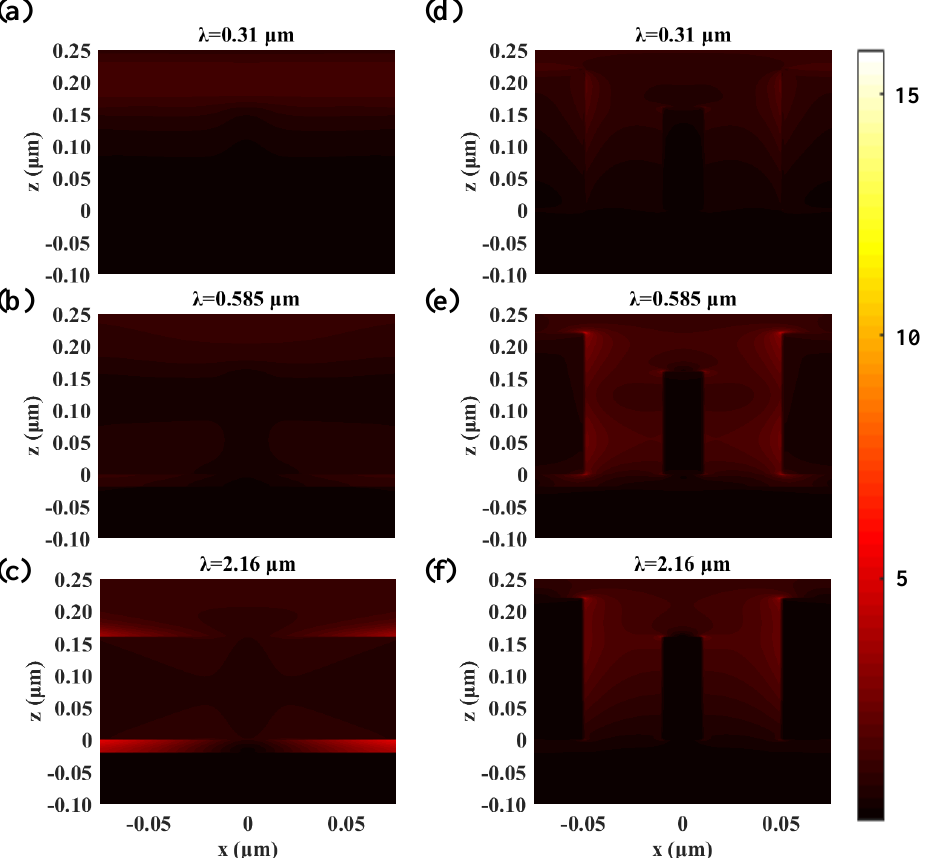
Figure 3. Electric field distribution of the absorber at different wavelengths. ( a – c ) The electric field distributions of the absorber in the plane of y = 0 at three wavelengths of 310, 585 and 2160 nm, respectively. ( d – f ) The electric field distributions of the absorber in the plane of y = 75 nm at three wavelengths of 310, 585 and 2160 nm, respectively.